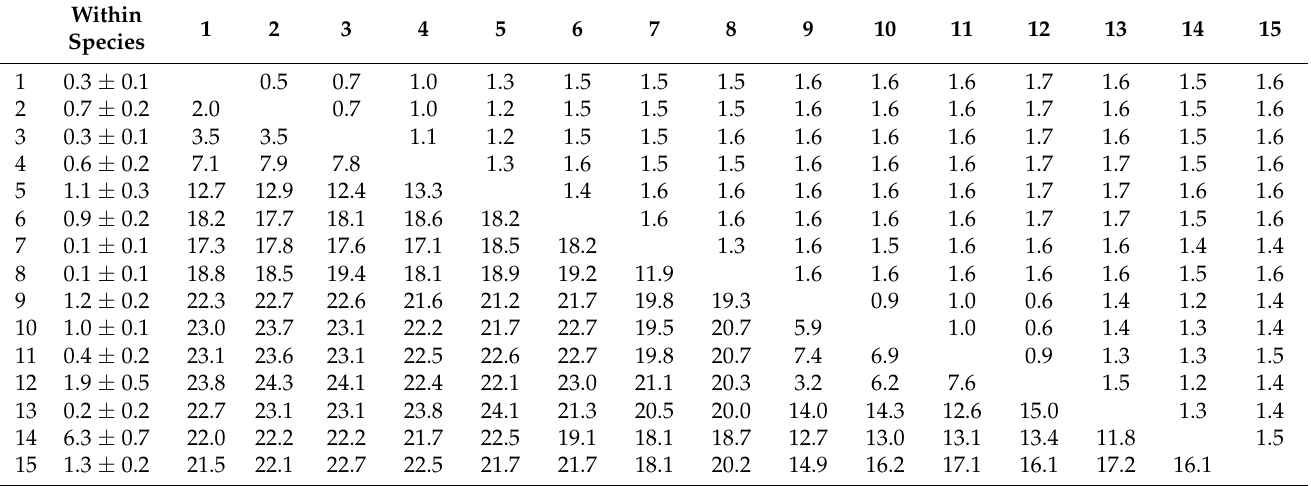
Table 1. Evolutionary divergence over sequence pairs within and between Daphnia species (below the diagonal—uncorrected p -distances, %; above the diagonal—standard error estimates) based on the full 12S dataset (original sequences plus GenBank). The analysis involved 295 nucleotide sequences. Note: 1— D. longispina s.str. “Siberian” clade A; 2— D. longispina s.str. “European” clade